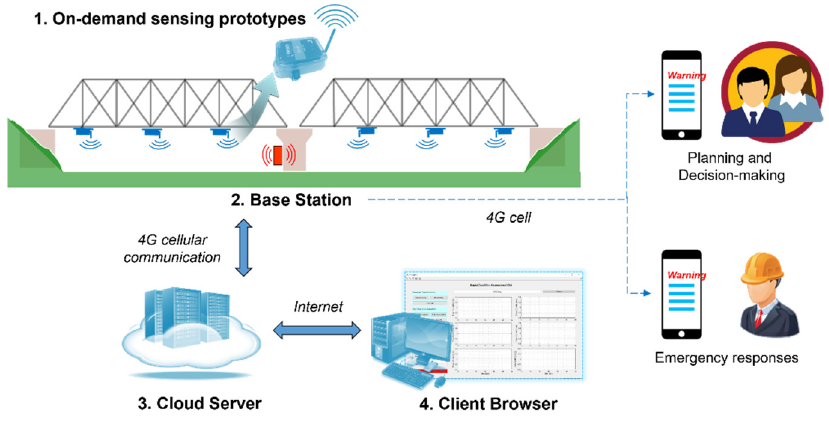
Figure 4. Data collection and transmission framework for bridge impact monitoring.